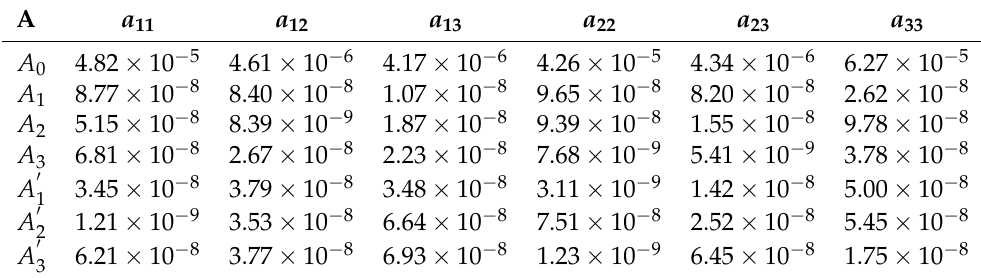
Table A4. The table shows the setting for coefficient matrix of exponential function and A i and A (cid:48) represents the entries in each coefficient matrix on position { i } , i = 1, 2, ,3; j = 1, 2